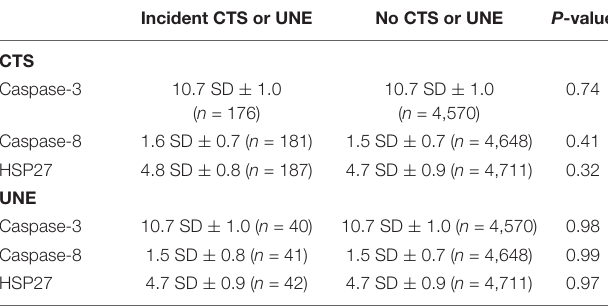
TABLE 2 | Levels of caspase-3, caspase-8 or HSP27 and incidence of CTS and